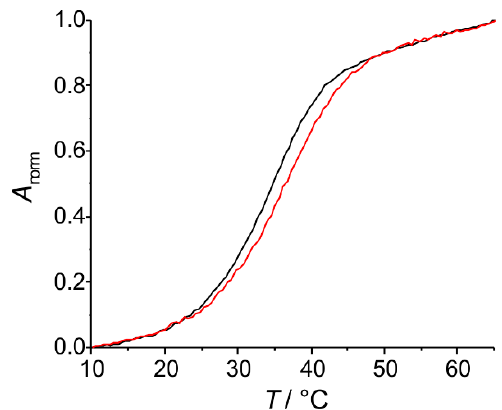
Figure 1. UV melting curves of the duplex comprising a central 6PP:6PP base pair in the absence (black) and presence (red) of one equivalent of AgNO 3 .